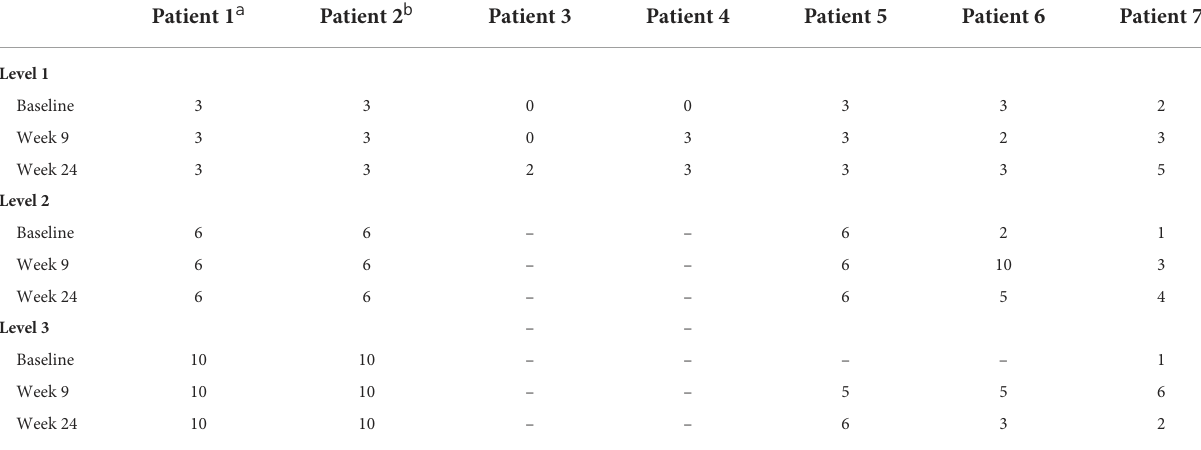
TABLE 2 Number of actions performed by each individual patient in the matching-pair